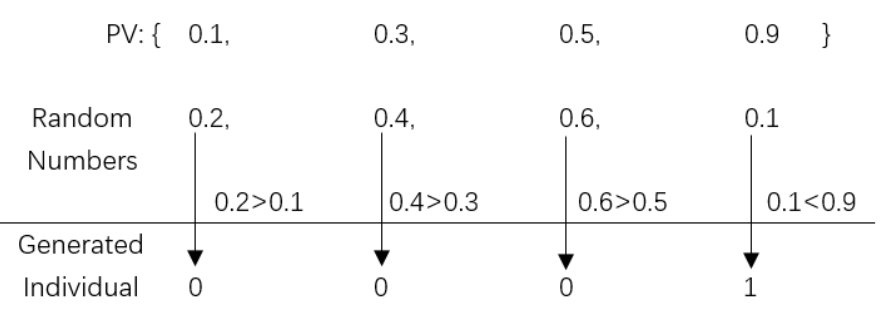
Figure 2. An example of generating an individual through